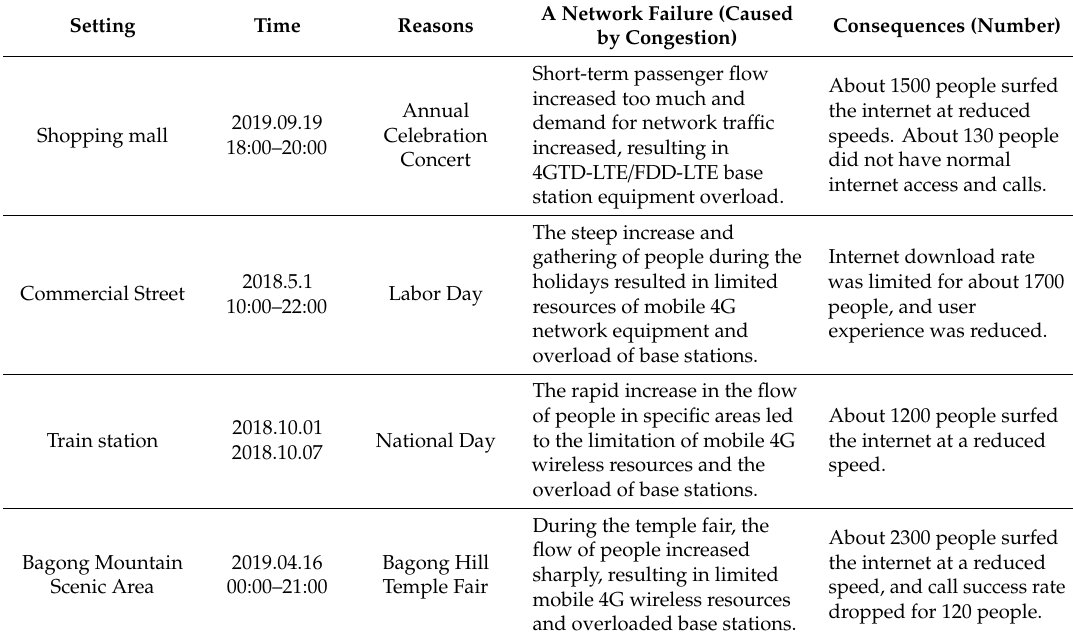
Table 1. Network accidents caused by increased tra ffi